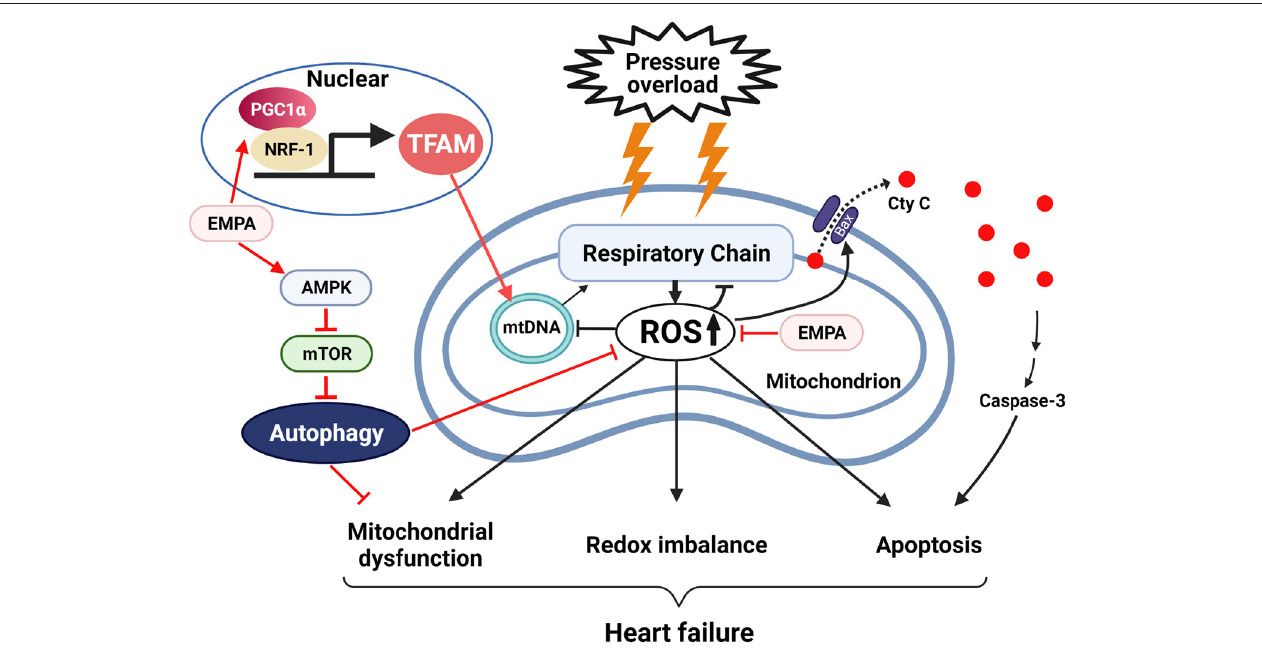
FIGURE 7 | Empagliflozin improves mitochondrial function, restores redox homeostasis and reduces apoptosis in heart failure. EMPA, empagilflozin; NRF-1, nuclear respiratory factor 1; TFAM, mitochondrial transcription factor A; mtDNA, mitochondrial DNA; ROS, reactive oxygen species; AMPK, adenosine monophosphate-activated protein kinase; mTOR, mammalian target of